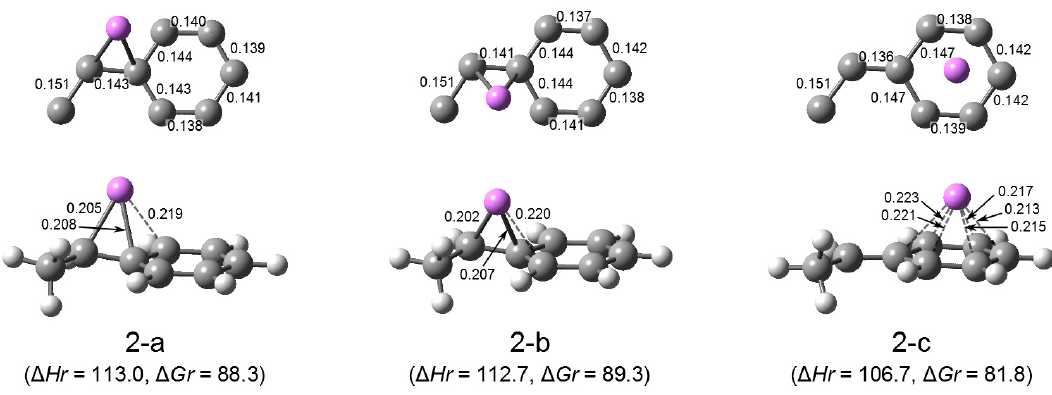
Figure 2-1. Optimized geometries and relative energies of HStLi in the gas phase. The small drawing on the upper part of each structure is the simplified overhead view of the lower drawing. C–Li distances less than 0.225 nm are shown in the lower drawings, and C–C bond distances are shown in the upper drawings. ∆ Hr and ∆ Gr , the relative enthalpy and relative free energy, are expressed in kJ·mol –1 .